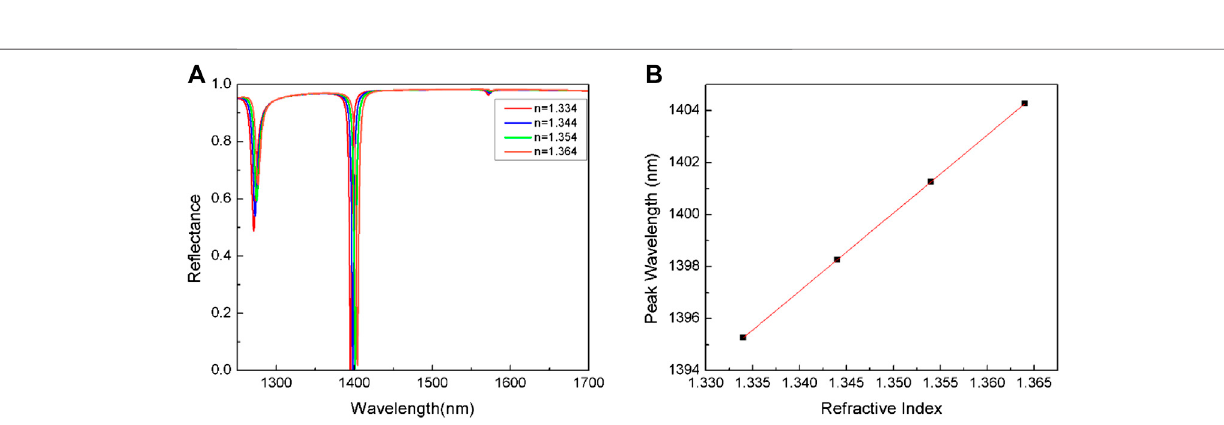
Frontiers in Physics |